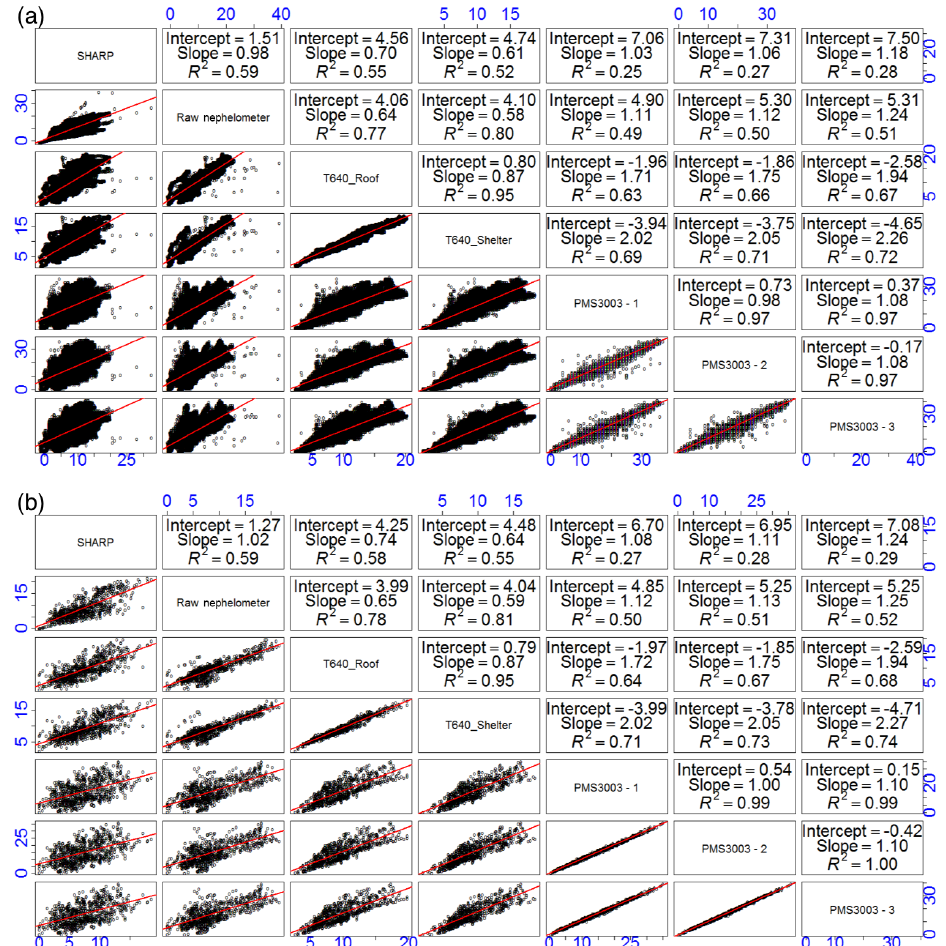
Figure 6. Pairwise correlations between (a) 1min aggregated PM 2 . 5 mass concentrations (µgm − 3 ) and (b) 1h aggregated PM 2 . 5 mass concentrations (µgm − 3 ) of the SHARP, the SHARP’s nephelometer, the two T640 sensors, and the three uncalibrated PMS3003 sensor packages between 30 June and 31 July 2017 at U.S. EPA RTP. In both panels (a) and (b) , the upper right set of panels includes the intercept, slope, and R 2 of linear regression models using the ordinary least-squares (OLS) method; the lower left set of panels shows the linear regression lines superimposed on pairwise